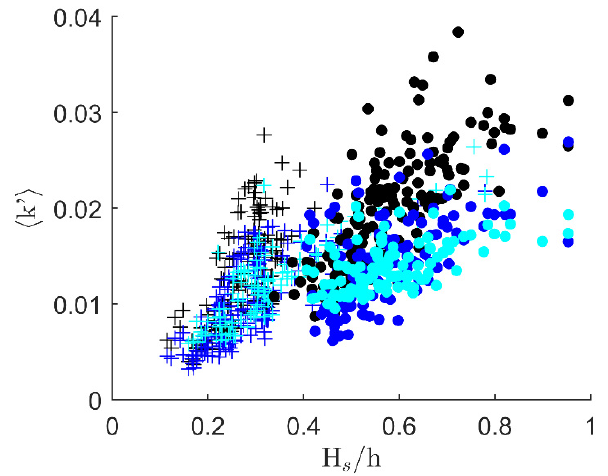
Figure 5. Record-averaged < k’ > at two beaches dominated by swell waves with typically plunging breakers (dots) and wind waves breaking predominantly as spillers breakers (crosses). Turbulence was measured at nominal elevations of z = 50 cm (black symbols), z = 20 cm (blue symbols), and z = 5 cm (light blue). Modified from Christensen et al. [74].